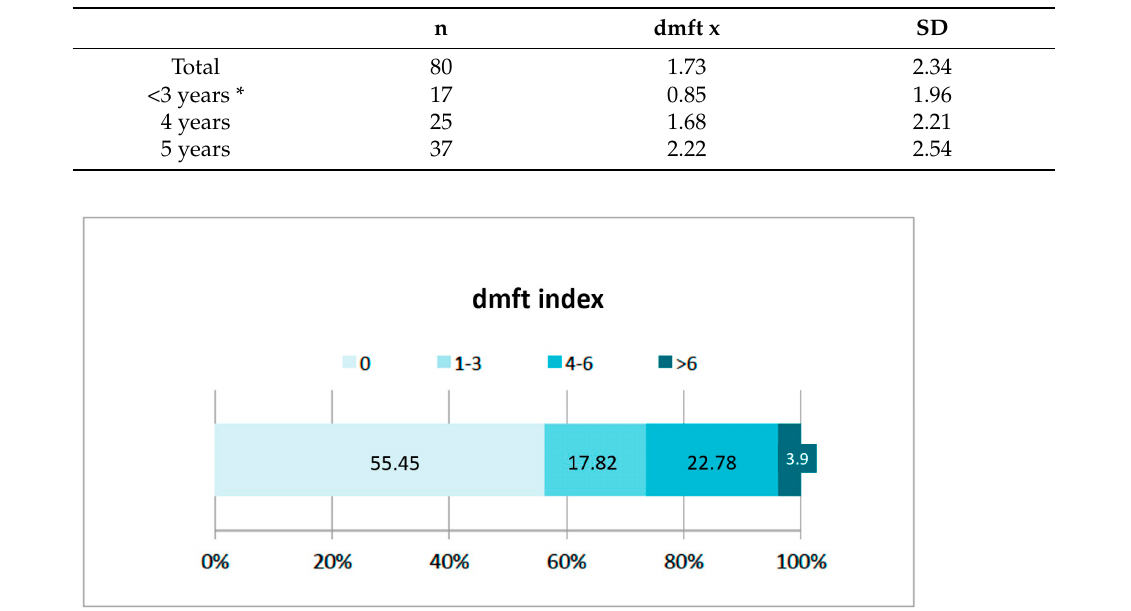
Table 3. Dmft per age (mean and SD.) * Excluded a 10-month-old child.